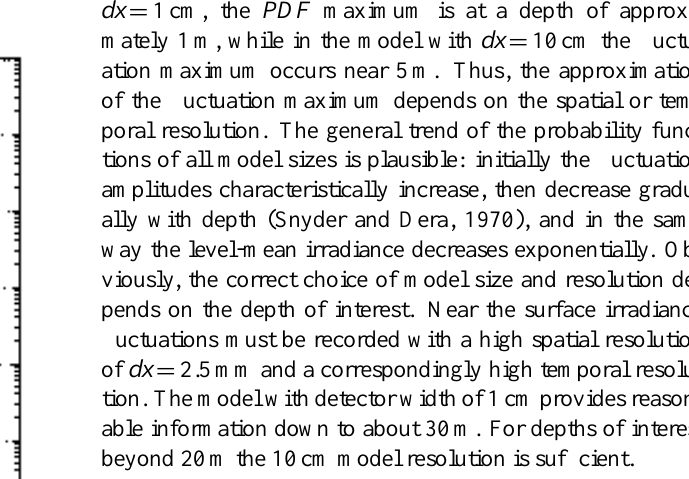
are additionally marked (30 Oct. 2009). 4 m